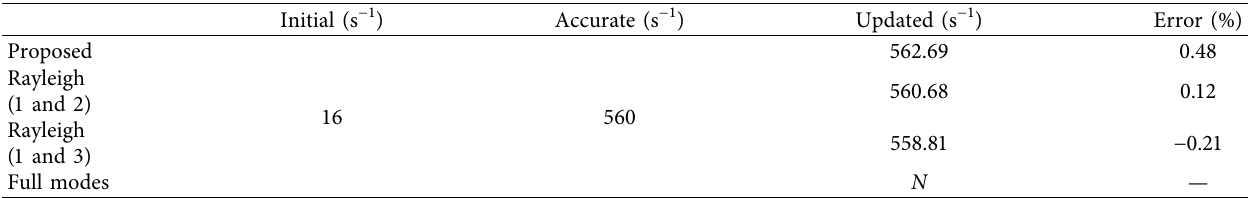
Table 3: Comparison of the relaxation parameter μ before and after updating for case